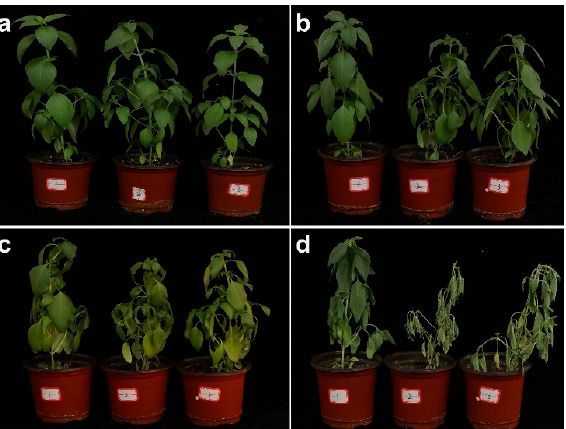
Figure 1. Phenotype of basil under heat stress. ( a ) Phenotype of control group (CK), ( b ) phenotype of high-temperature treatment for 1 d, ( c ) phenotype of high-temperature treatment for 3 d, ( d ) phenotype of high temperature treatment for 5 d.